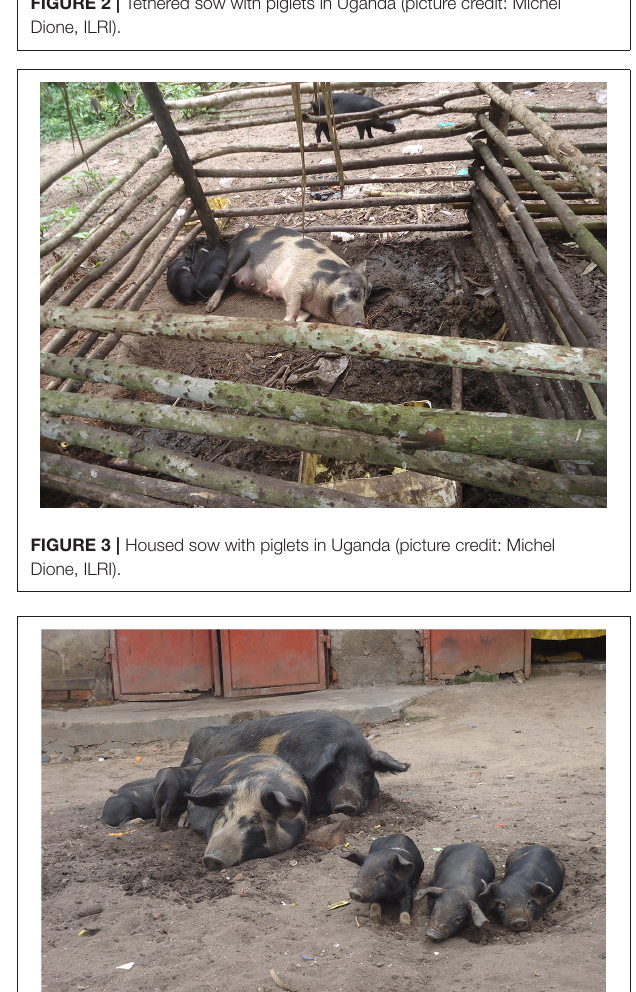
for two years. It has been shown to remain infective in smoked and salted pork. ASFV is highly resistant to putrefaction and can remain in feces for at least 11 days and in